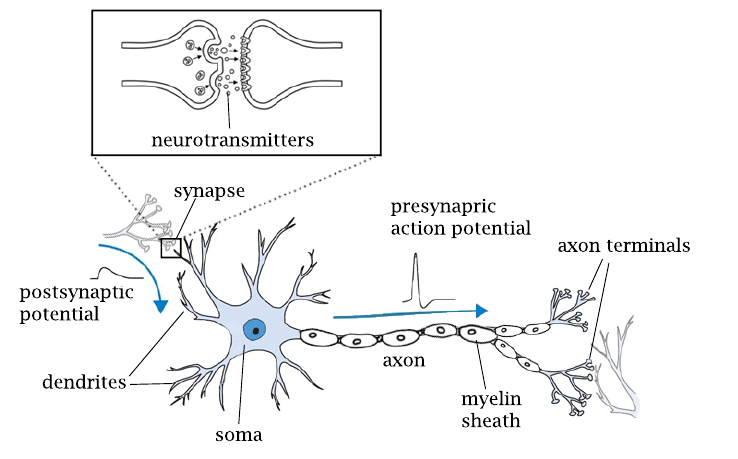
Figure 1. A typical structure of a biological neuron and